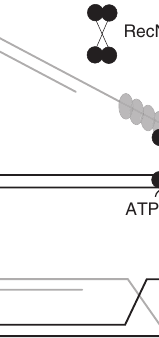
Figure 7 | Model for the role of RecN in the stimulation of the RecA strand invasion step of DNA DSB repair. RecN interacts with RecA bound to a ssDNA region of one DNA molecule and with a target duplex DNA molecule. In vitro , this scenario leads to a relatively high rate of ATP hydrolysis by the RecN protein. One possible function of RecN ATP usage is the movement of the complex along or between potential target DNA molecules as part of a global search for homology. Alternatively, RecN protein may be affecting RecA–DNA filament dynamics and/or the topological state of the DNA, as discussed in the